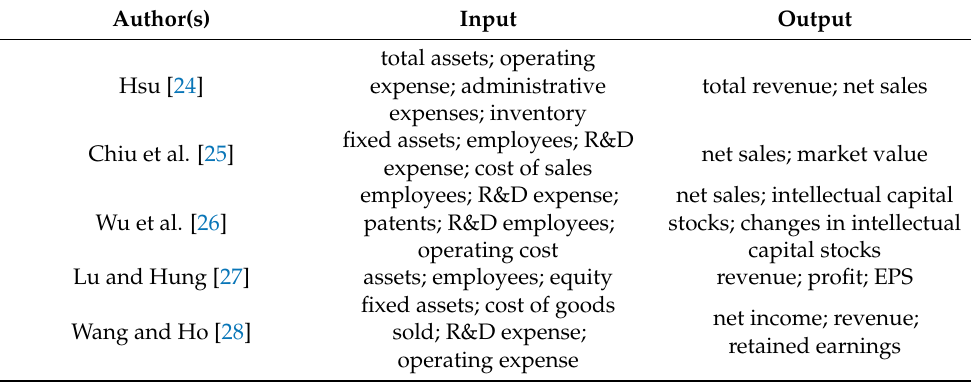
Table 2. List of input and output factors from previous